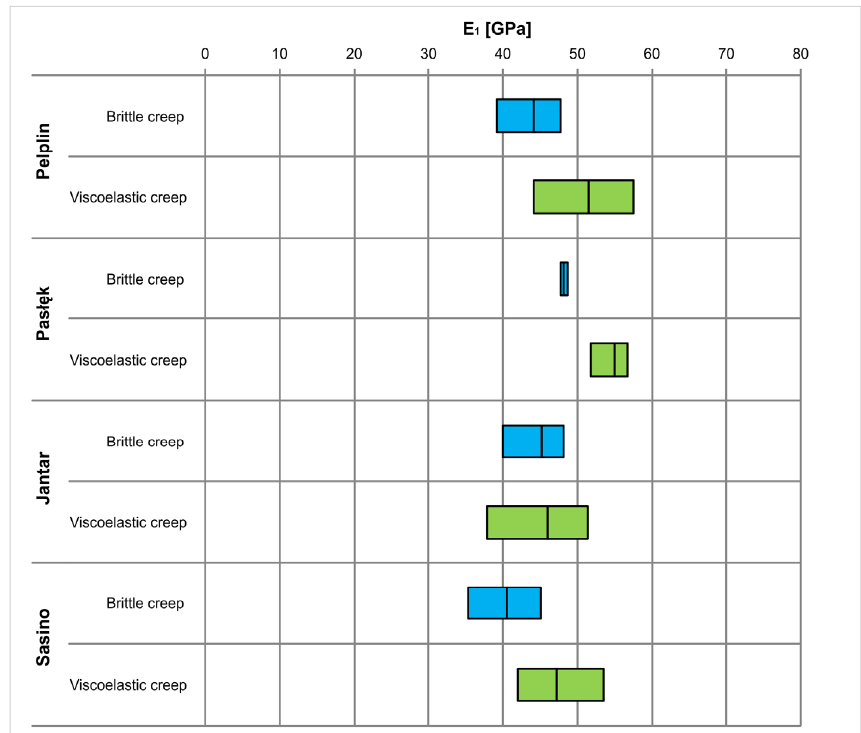
Figure 15. Comparison of ranges of Young’s modulus from brittle creep and viscoelastic creep tests for particular lithostratigraphic units.